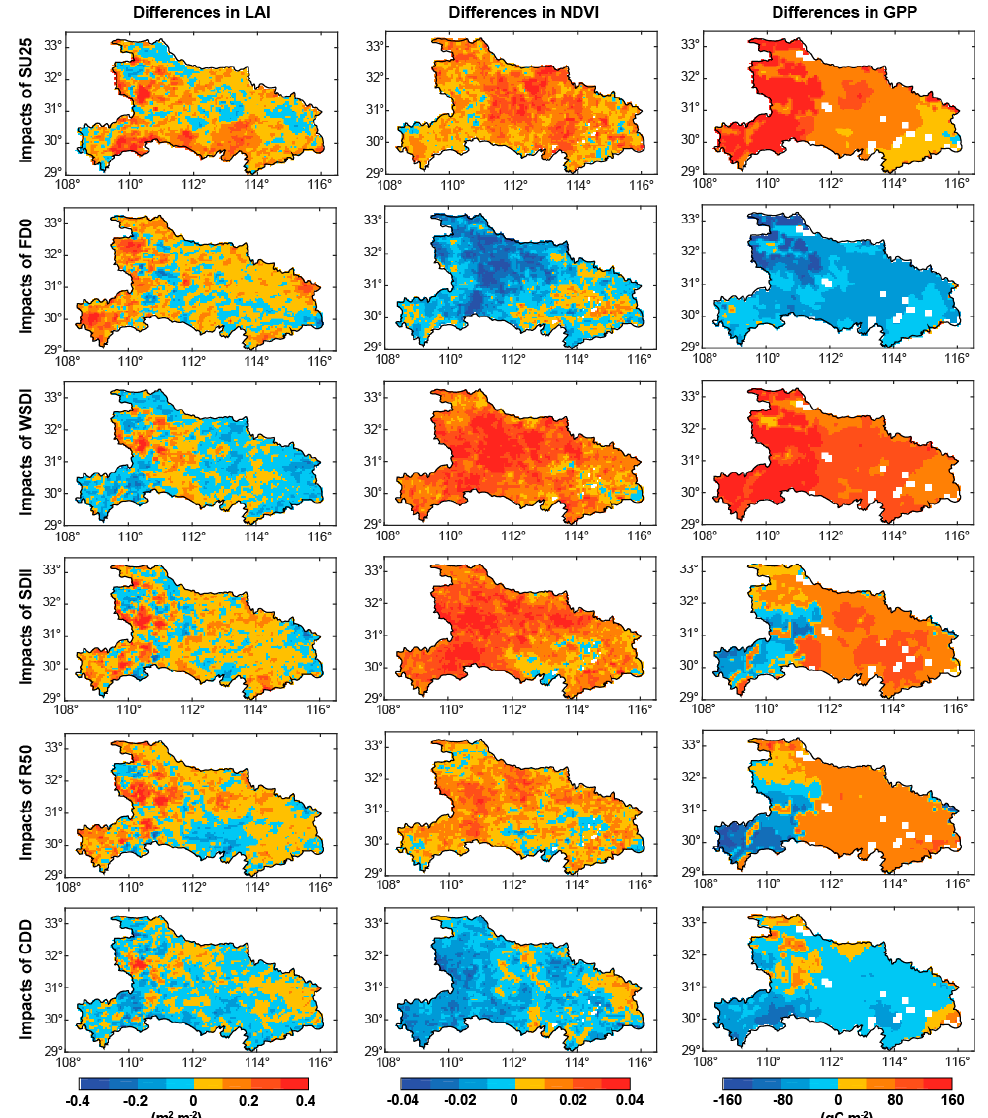
Figure 6. Spatial patterns of the ecological response to changes in the six climate indices. Years with the five highest values (FH) and the five lowest values (FL) in each climate index are chosen as the most significant and insignificant impact years for that climate index, respectively. The impacts are expressed as differences in the ecosystem variables between the selected years for the FH and FL. Notice that linear trends between 1982 and 2015 were removed in each pixel before calculating the